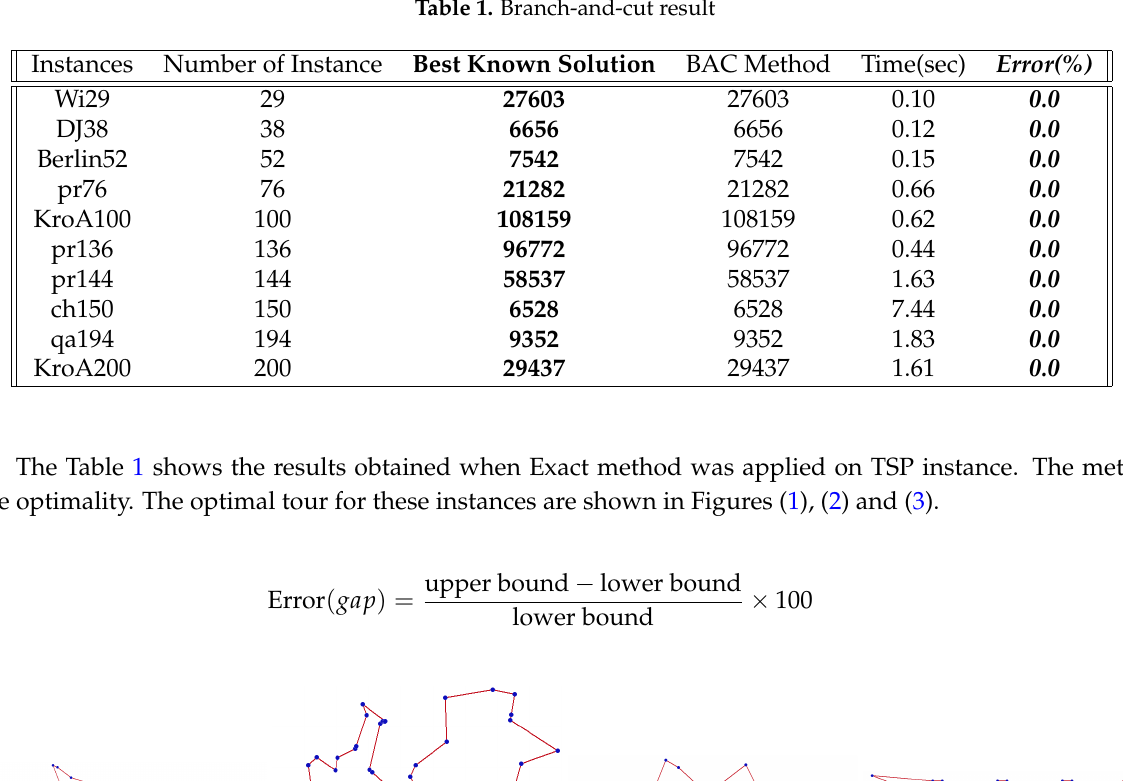
Table 1. Branch-and-cut result